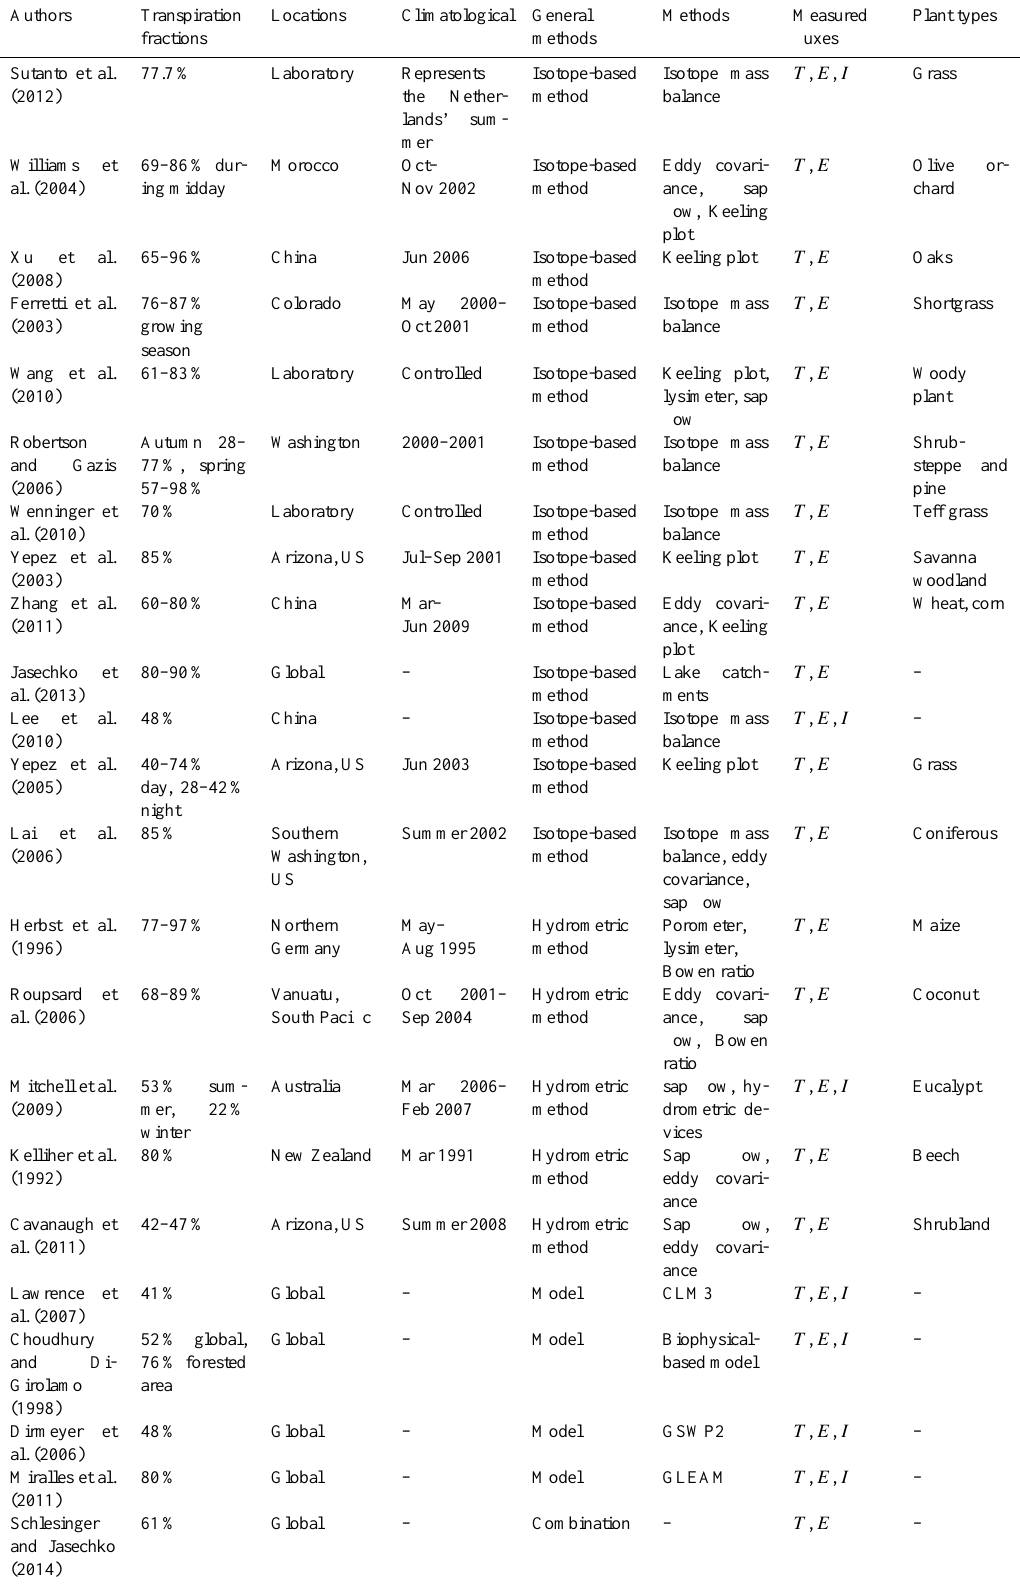
Table 2. Transpiration fraction from several past partitioning studies. T , E , and I stand for transpiration, soil evaporation and interception,